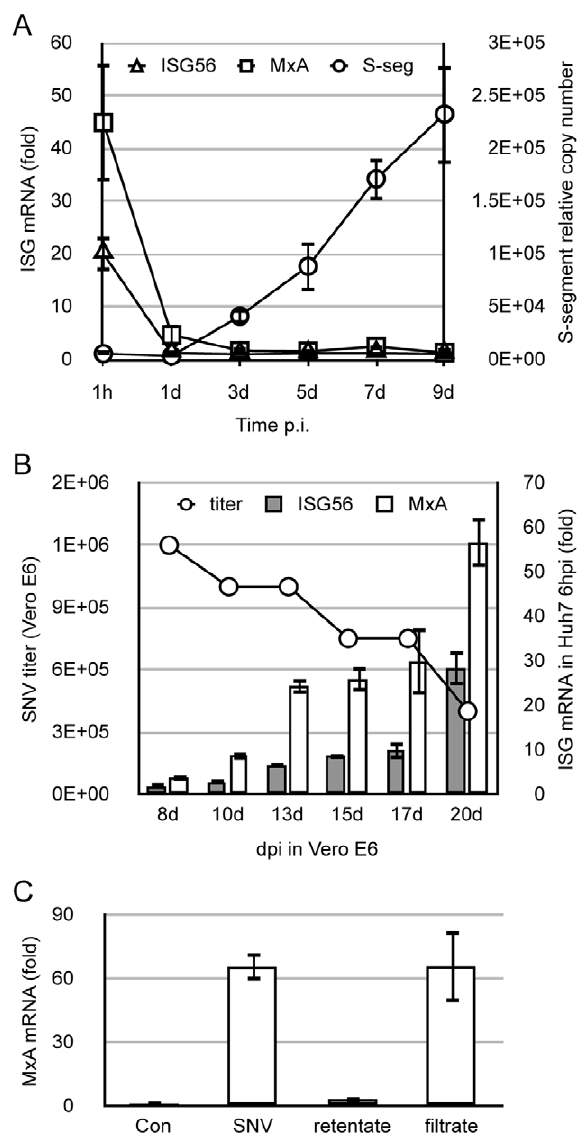
Figure 1. SNV stocks induce innate responses in Huh7 independent of titer, replication, and intact virus particles. (A) Huh7 cells were infected with SNV at an MOI=1 for 1 h. At the time points indicated, cellular mRNA was isolated and used to quantitate viral S-segment RNA (right y-axis) and ISG expression (left y-axis) using qRT- PCR. (B) Vero E6 cells grown in 75 cm2 tissue culture flasks were inoculated with SNV (10 ffu) for 1 h and supernatants were collected at the time points indicated on the x-axis. Virus was then titrated on fresh Vero E6 cells (left y-axis) or used to infect Huh7 cells at equal volumes. ISG56 and MxA expression was measured by qRT-PCR 3 hpi (right y-axis). (C) SNV from 20 dpi Vero E6 stocks was applied to a 100-kDa filter and centrifuged for 10 min. The retentate and filtrate was resuspended to the loading volume and applied to Huh7 cells for 3 h. MxA expression was then measured using by qRT-PCR of total cellular RNA and compared to untreated control(Con) cells. All real-time qRT-PCR results arereported as the mean 6 SEM from triplicate biological experiments.